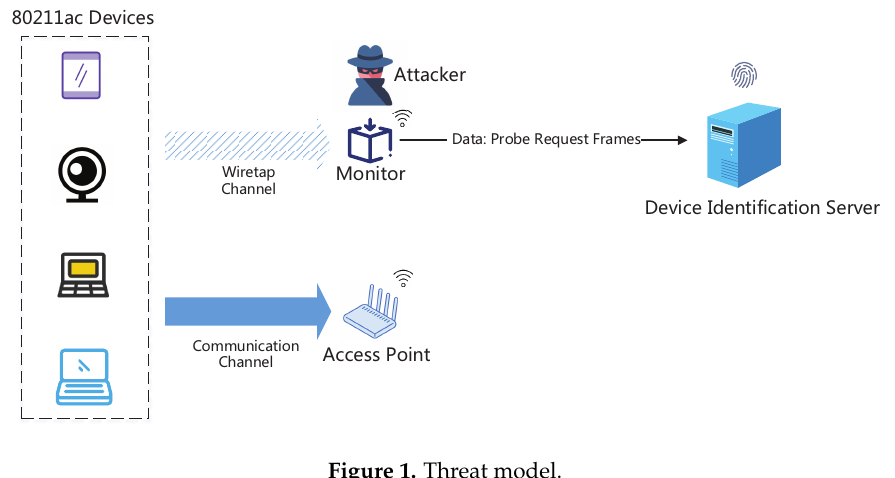
Figure 1. Threat model.